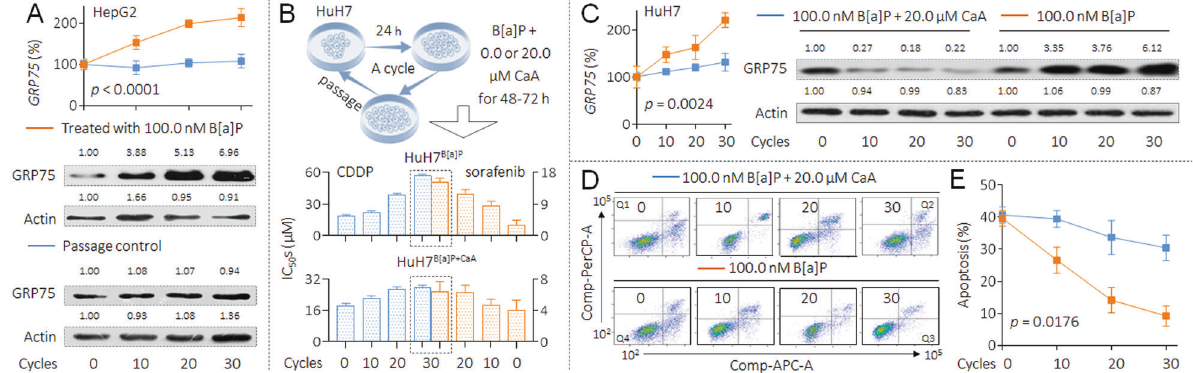
Fig. 3 Involvement of GRP75 in B[a]P-induced MDR in HCC cells. A Triplicate qPCR and western blot analysis of the levels of GRP75 mRNA and protein in HepG2 PC and HepG2 B[a]P cells. B , up The fl ow chart for the establishment of B[a]P-induced MDR and intervention cell model in HuH7 cells. (B, bottom) The cell viabilities were determined in triplicate, and the IC 50 s were calculated. C Triplicate qPCR (left) and western blot (right) analysis of the levels of GRP75 mRNA and protein in HuH7 B[a]P and HuH7 B[a]P + CaA cells. D and E Flow cytometric analyses of the percentage of cells in apoptosis under the treatment of 10.0 μ M cisplatin.